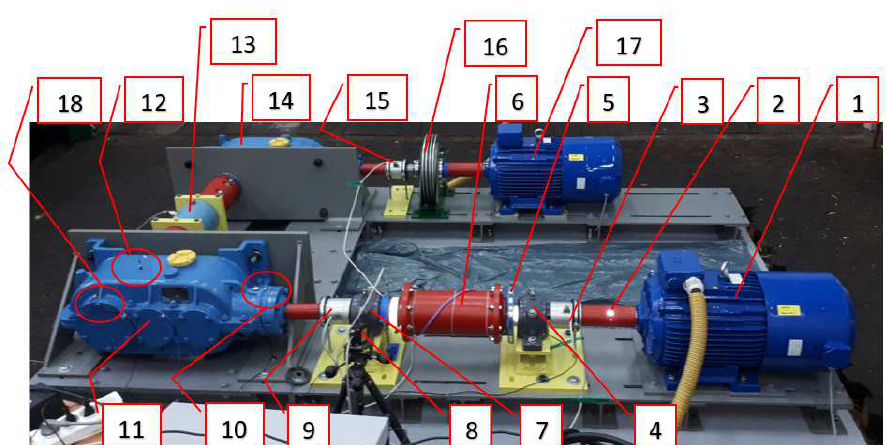
Figure 5. Type PAT-KW3 toothed gear: ( a ) schematic diagram, ( b ) connection dimensions—front and right side view [70].